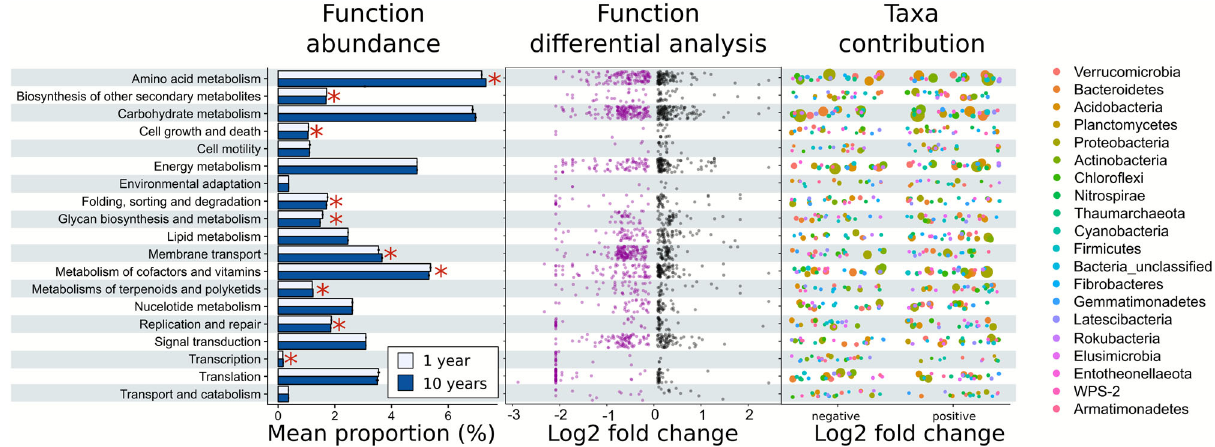
Fig. 5 Potential functional capabilities and acquisition strategies of soil microbial communities. The three graphs show results from PICRUSt2 comparing 1-year to 10-year drought. This revealed potential enrichment or depletion (respectively, positive and negative Log2 fold changes) of many functional traits of the microbial community related to important functions in response to drought history. The left graph shows the mean proportion of level 2 KEGG Orthologies within the bacterial community for the 1-year and 10-year treatments. Colour indicates soil treatment (1 year = light blue, 10 years = blue). Red asterisks indicate signi fi cant differential abundances of the overall group. The middle graphs represent the number of functions that were enriched (black circles) or depleted (purple circles) using DESeq2 (respectively, positive and negative Log2 fold changes). The right graph represents the microbial groups (bubble size represents bigger or smaller frequency of ASVs in each group of function within each phylum) contributing to enriched or depleted functions (respectively, positive or negative). Individual phylum colour are described in the fi